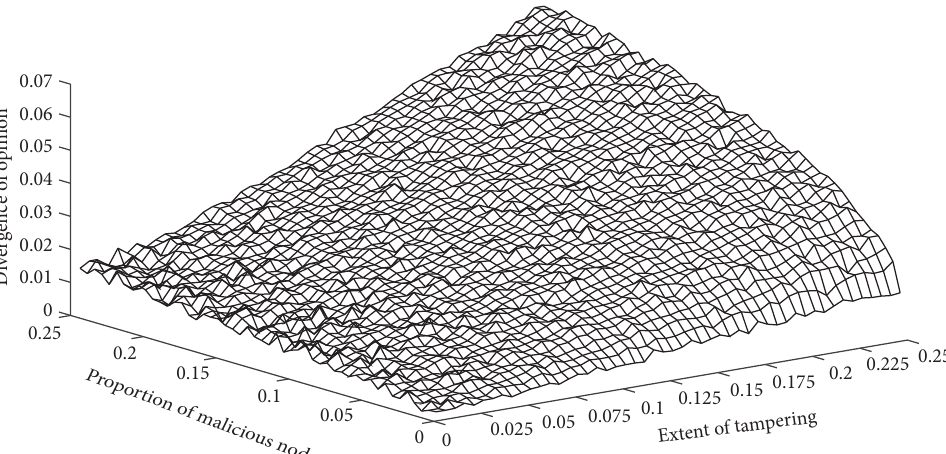
Figure 4: Joint distribution diagram.